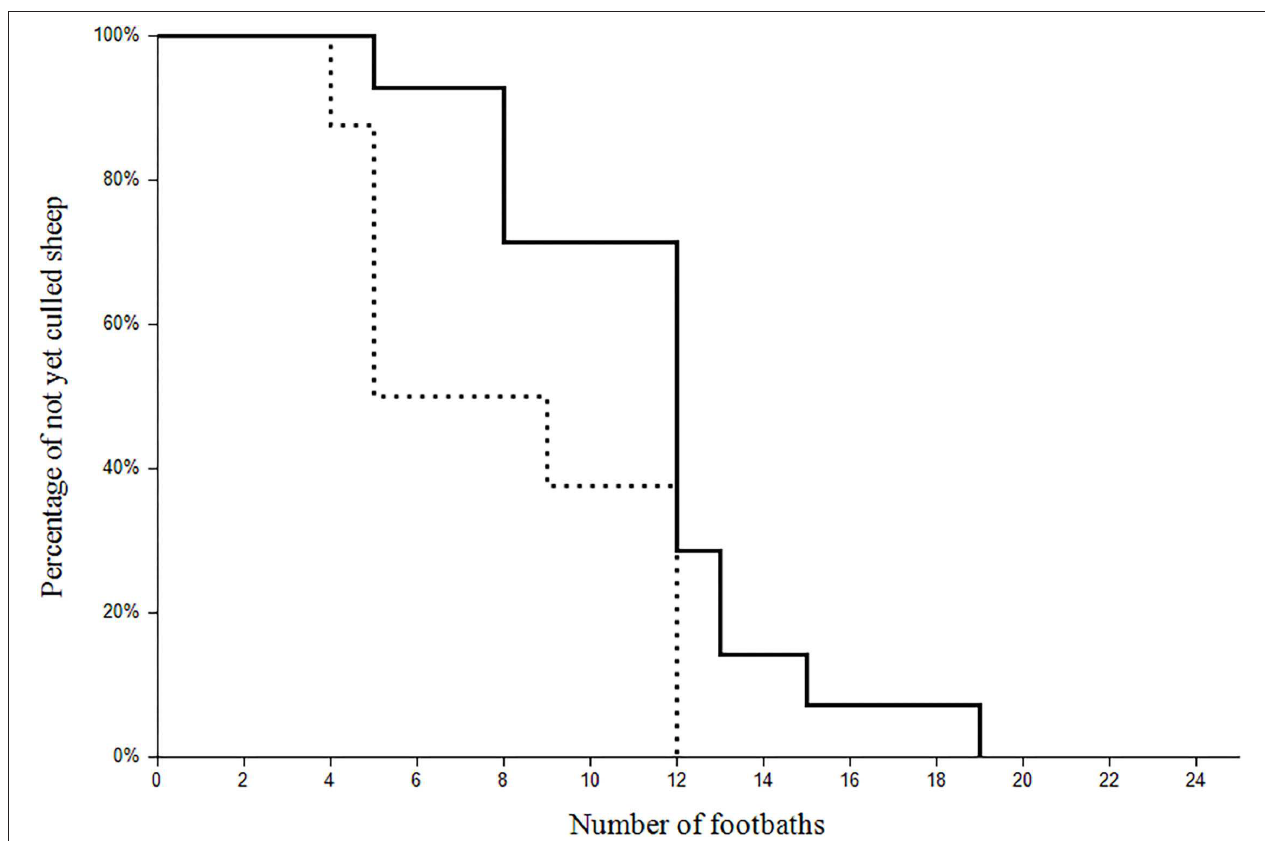
FIGURE 3 | Survival plot of the of the 22 clinically affected sheep culled during the study. The x -axis refers to the number of the footbaths and the y -axis represents the percentage of the not yet culled sheep with (dotted line; n = 8) or without (continuous line; n = 14) a co-existing